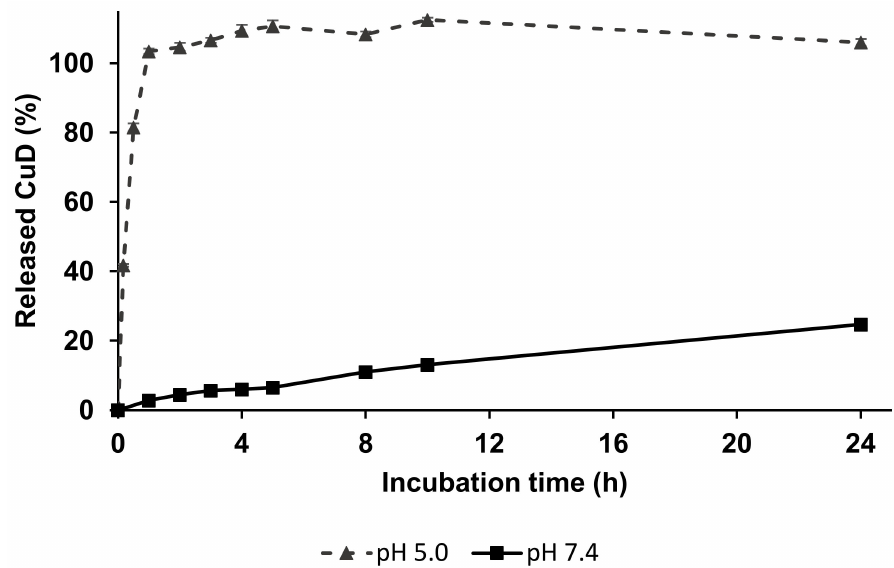
Figure 2. Release of CuD from LP-CuD incubated in 0.1 M phosphate buffer (containing 0.05 M NaCl) at pH 5.0 and pH 7.4 at 37 ◦ C. At indicated time periods, released CuD was determined by HPLC after extraction into chloroform. Values are the mean ± SD ( n =